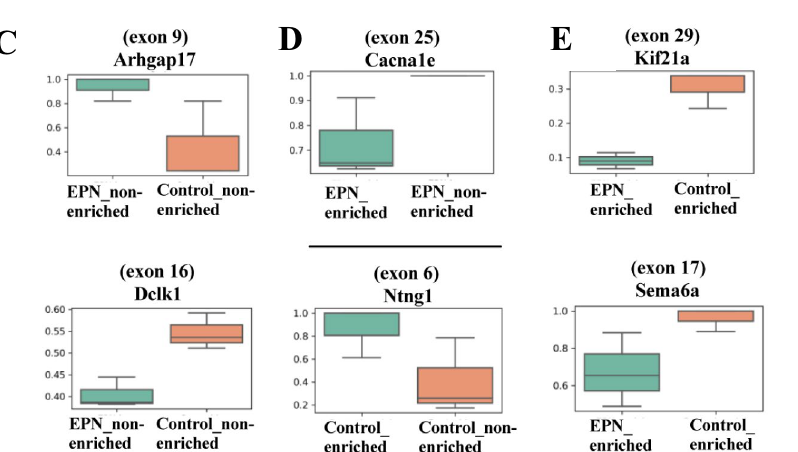
Figure 5. Alternative splicing (AS) events affected by Pb exposure and environmental enrichment. ( A ) Illustration of the five AS event types examined. ( B ) Types of AS events and number of involved genes detected in exposure-wise comparisons. The most significantly enriched AS event was skipped exon events. ( C – E ) Examples of differential exon skipping events in genes with neuronal functions in different exposure-wise comparisons. Boxplots showing the shifts in percent spliced in (PSI) values. Exon 9 in Arhgap17 transcripts was significantly more included in the CA1 of Pb exposed, non-enriched animals compared to control, non-enriched animals. ( C ) Lead exposure resulted in a decrease in inclusion of exon 16